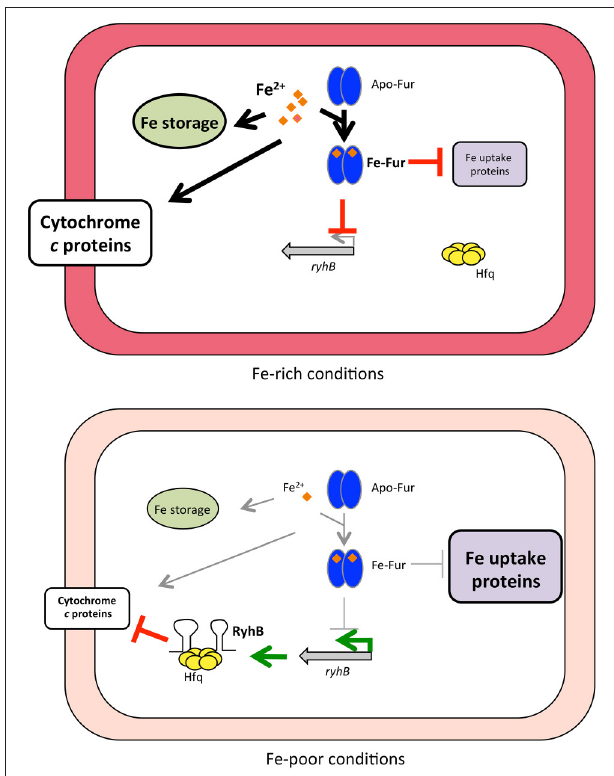
FIGURE 6 | Model of how iron availability controls RyhB regulation of c -type cytochromes. Under iron-rich conditions, Fur associates with Fe 2 + (orange diamonds) and binds to Fur-binding sites in the promoter region of target genes, leading to repression of expression (indicated by red blocked lines) of RyhB and other genes (e.g., iron uptake genes). Fur repression is relieved when iron becomes limiting and RyhB is produced (indicated by green arrows), as well as other Fur-repressed genes (including iron uptake genes). RyhB with the aid of the RNA chaperone Hfq represses expression of numerous c -type cytochromes by promoting degradation of the mRNAs. Processes that are favored under either Fe-rich or Fe-poor conditions are shown with thick arrows or thick blocked lines, whereas processes that do not occur (or at diminished rate) are indicated with thin gray arrows or thin gray blocked